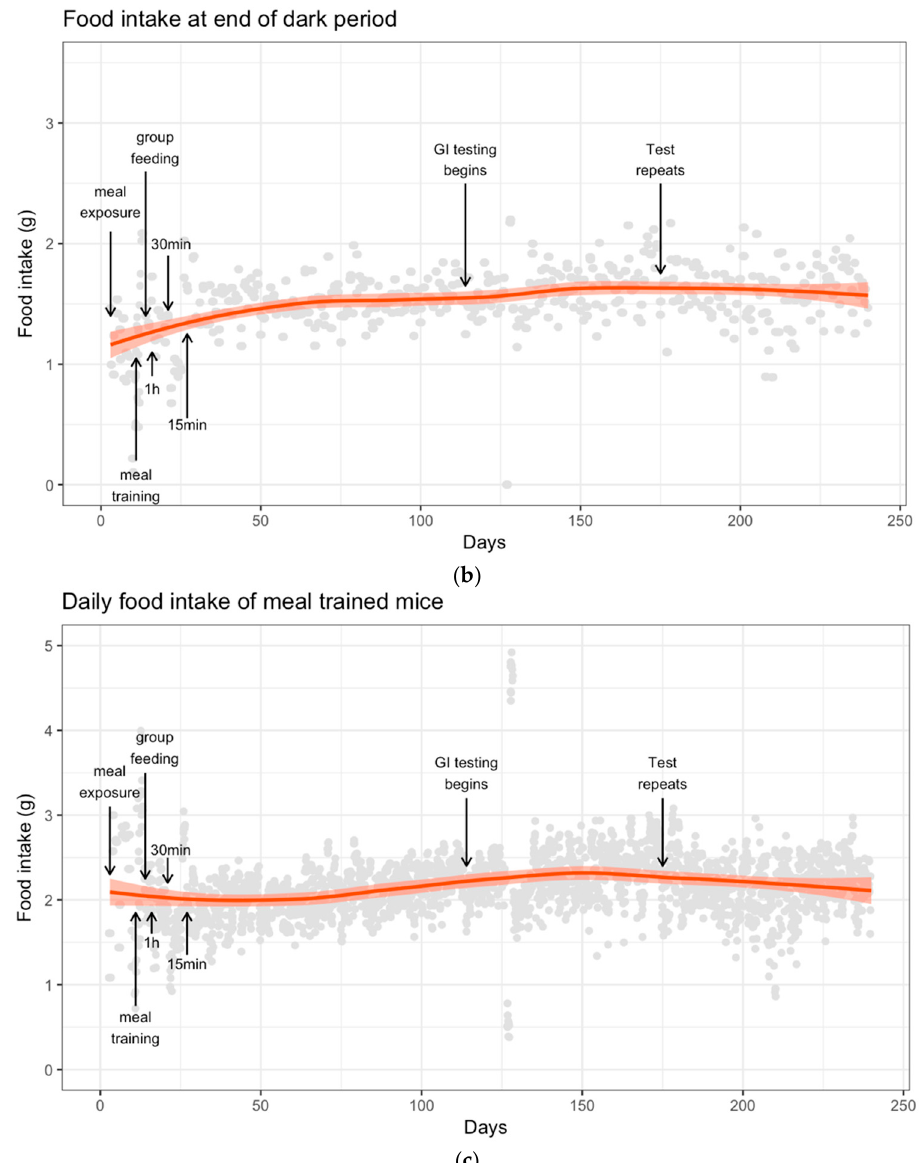
Figure 2. Smoothed mean of food intake ( a ) beginning of dark phase (7 a.m.—individual); ( b ) end of dark phase (4 p.m.—group); and ( c ) daily for the ten mice across the 250-day study. Mice were group fed for the vast majority of 4 p.m. feedings, but individually during the 7 a.m. meals (grey dots).